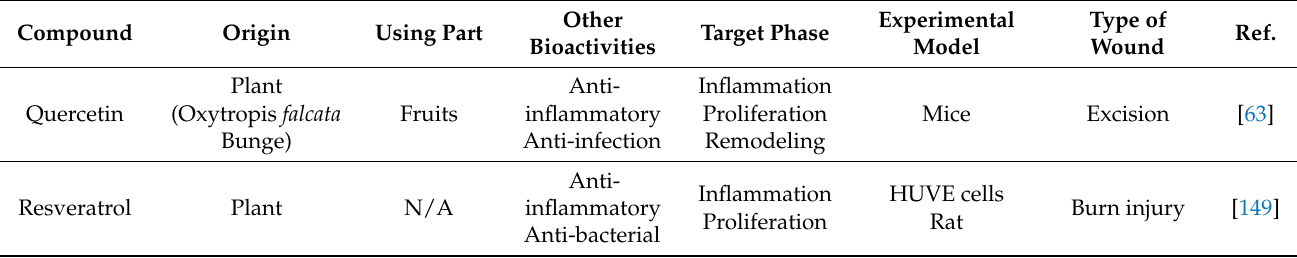
Table 2. Compounds with